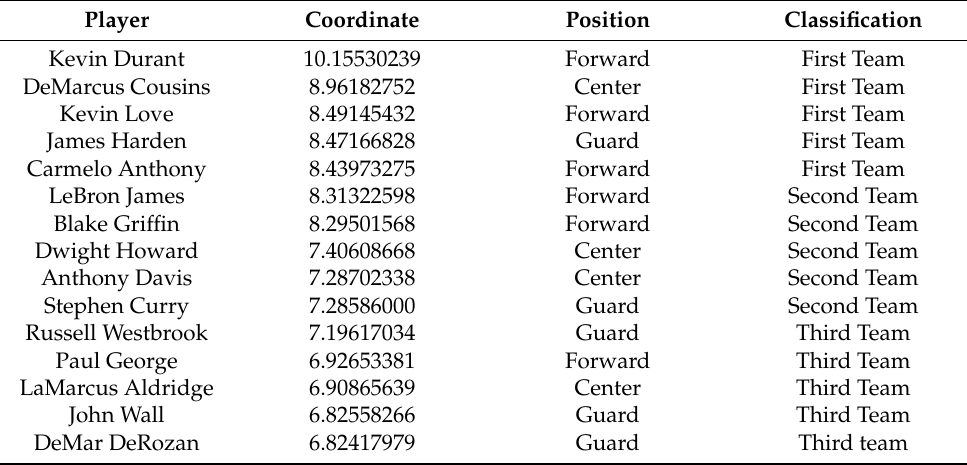
Table A1. All-NBA Teams’ selection through PC1, 2013–14 NBA Season. Player